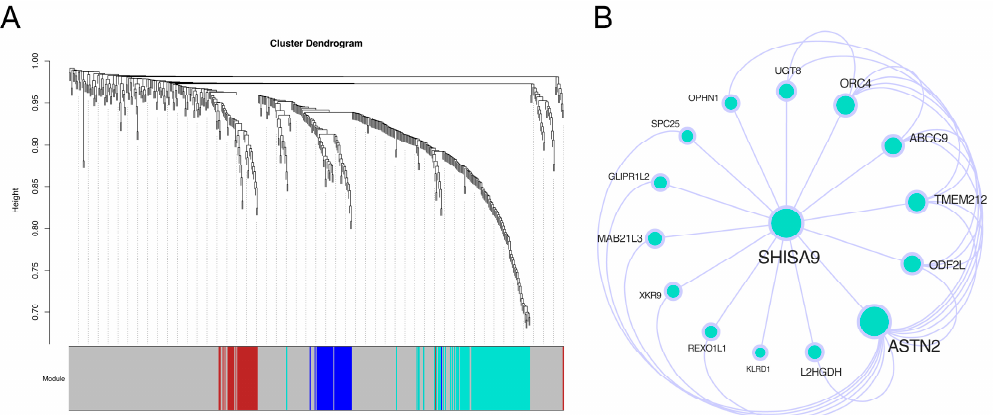
Figure 9. Identification of key genes. ( A ) WGCNA cluster dendrogram. At the bottom are the gene modules, which are colored differently. ( B ) WGCNA network diagram. The node size reflects the degree of the node: the larger the degree, the larger the node size.